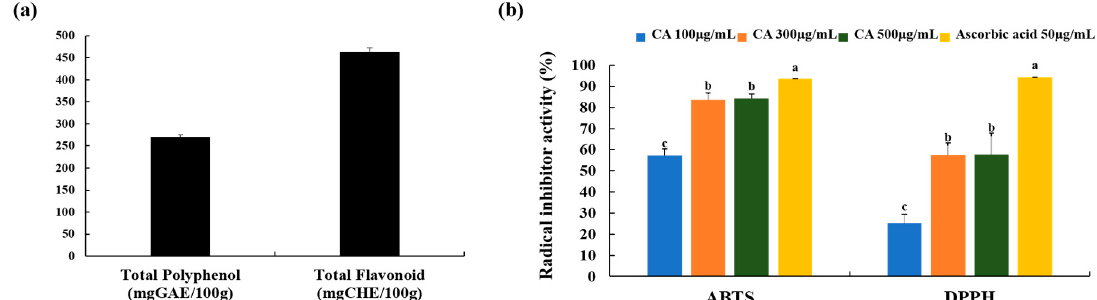
Figure 3. Polyphenol and flavonoid content, and antioxidant capacities of CA. ( a ) Total polyphenol and flavonoid; ( b ) 2,2’-azinobis-(3-ethylbenzothiazoline-6-sulfonic acid) (ABTS) and 2,2-diphenyl-1-picrylhydrazyl (DPPH) scavenging activity. Values represent the mean ± SD. Values with di ff erent letters were significantly di ff erent according to Duncan’s multiple range test ( p < 0.05). GAE: gallic acid equivalents, CHE: ( + )-catechin hydrate